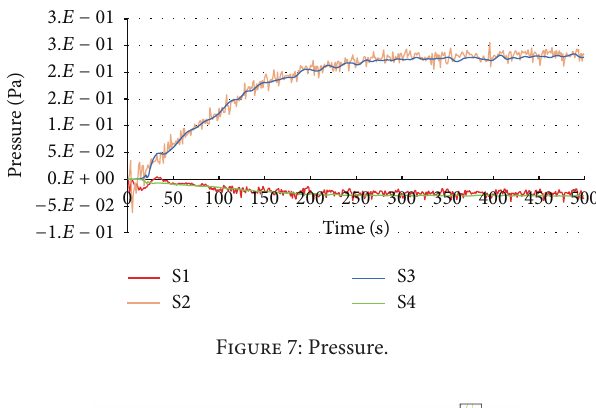
Figure 7: Pressure.